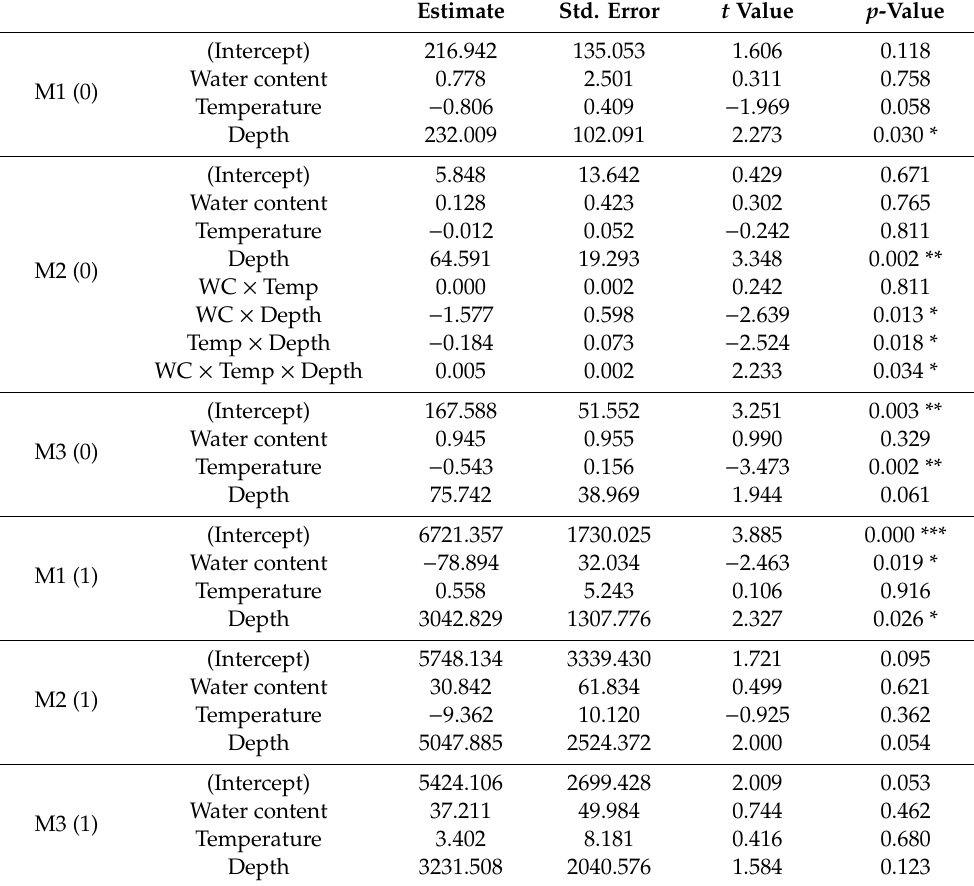
Table 4. Results of general linear models (GLM) performed with the bacterial growth data obtained immediately (0) and one (1) month after the heating in the three di ff erent soil mixtures (M1, M2